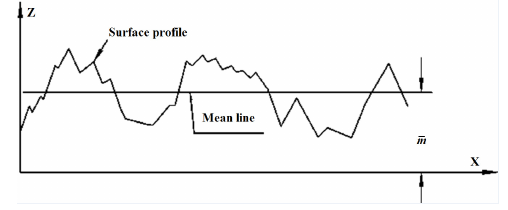
Figure 4. Schematic diagram of the arithmetical mean deviation ( R a ).